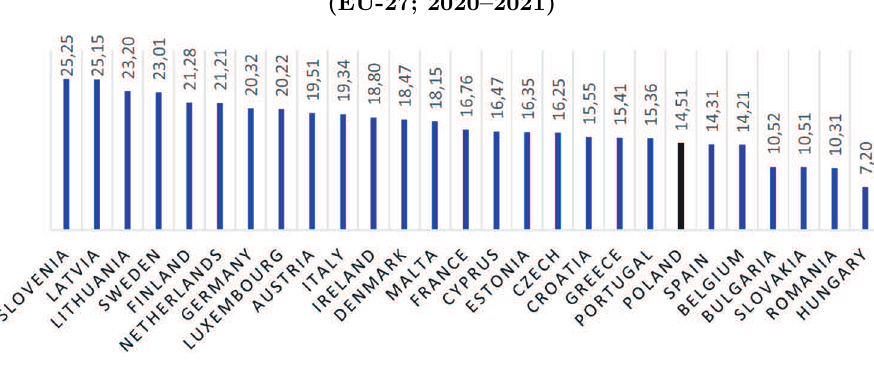
Source: (Governments’ Responses to Covid-19).